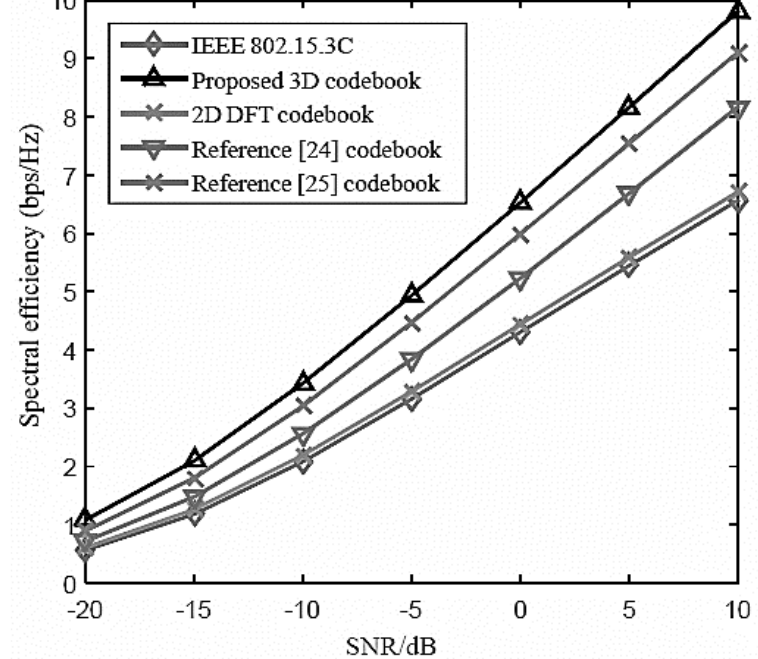
Figure 10. Spectral efficiency comparison versus SNR for the proposed 3D codebook scheme with other state-of-the-art schemes.